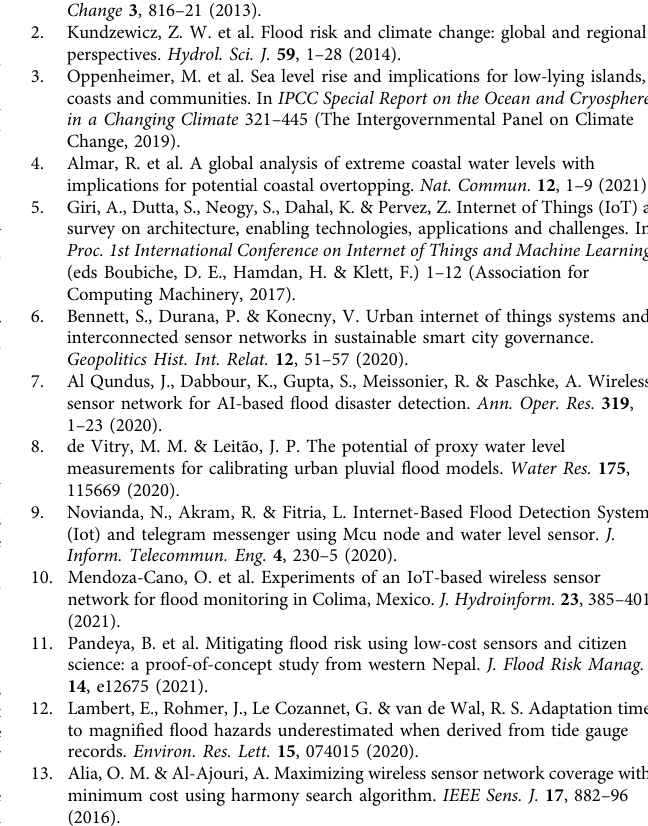
Fig. 6 Flowchart of overall methodology for multi-objective optimization and sensor location selection presented in this study. Inputs, processes, and decision points to select optimal solution locations for a total of N sensors are